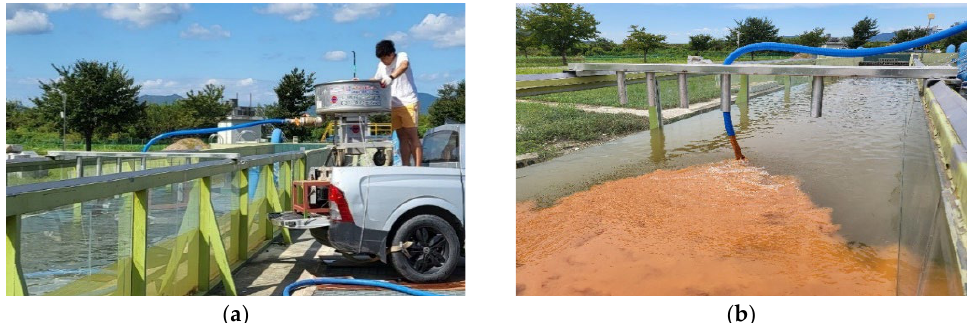
Figure 2. ( a ) Injection of red clay mixture using a 250 L mixer; ( b ) mixture injection method for Injection 3.